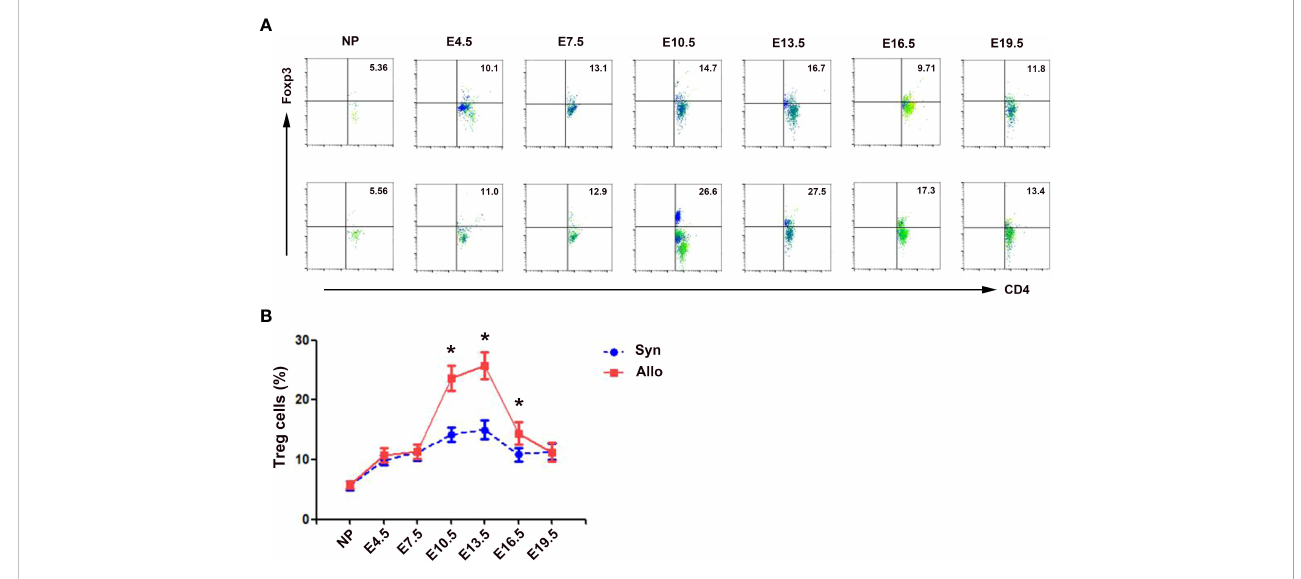
FIGURE 2 Percentages of decidua Treg cells in syngeneic and allogeneic pregnancies. (A) One representative experiment of the percentages of decidua Treg cells in syngeneic mice (upper) and allogeneic mice (lower) is shown. Numbers indicate the percentages of Foxp3 + CD4 + cells in CD4 + T cells (%). (B) A graphical summary of the percentages of decidua Treg cells is presented. Data are presented as mean ± SD (n = 6). * p < 0.01 vs the syngeneic mice. NP, non-pregnant group; Syn, syngeneic pregnant group; Allo, allogeneic pregnant